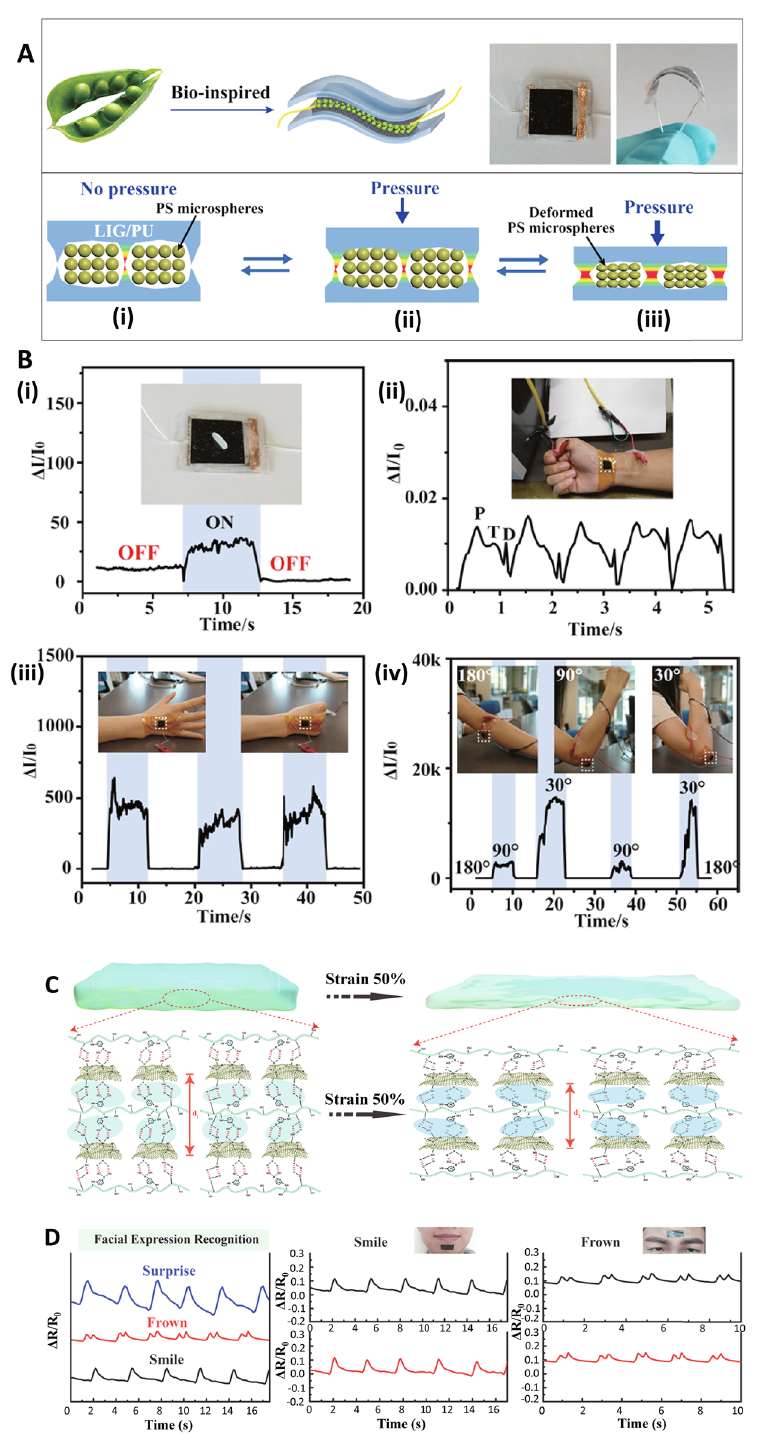
Fig. 8 A Schematic illustration of the bean pod-inspired healable pressure sensor and its mechanism. B Wearable sensing applications of the pressure sensor in the detection of ( i ) rice as a light object, ( ii ) blood pulse on the wrist, ( iii ) hand clenching, and ( iv ) elbow bending. Repro- duced with permission from Ref. [104]. Copyright, 2020 American Chemical Society. C Electrical properties of the GRSE-based sensors con- structed from 1-pyrenamine-modified graphene layers. D Sensing activity of the sensor in human motion detection for recognition of smile and frown. Reproduced with permission from Ref. [105]. Copyright 2022